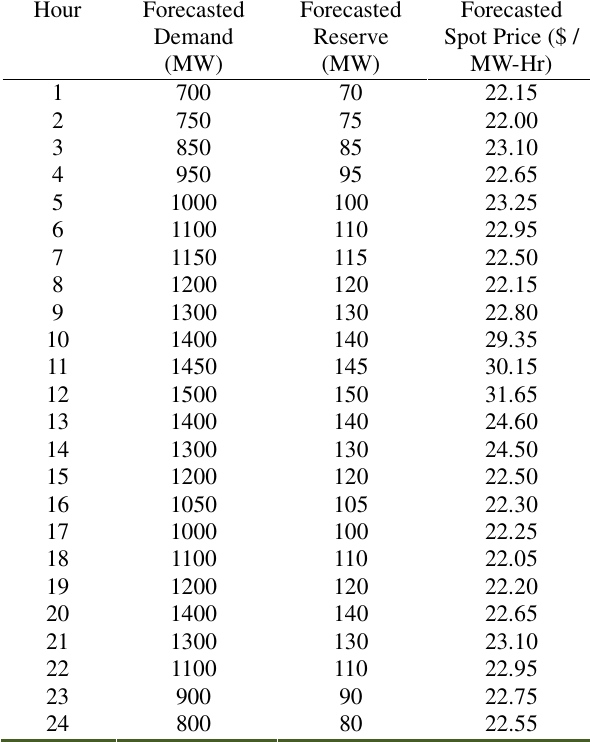
Table A2 Fuel cost data of 3 Generator Case